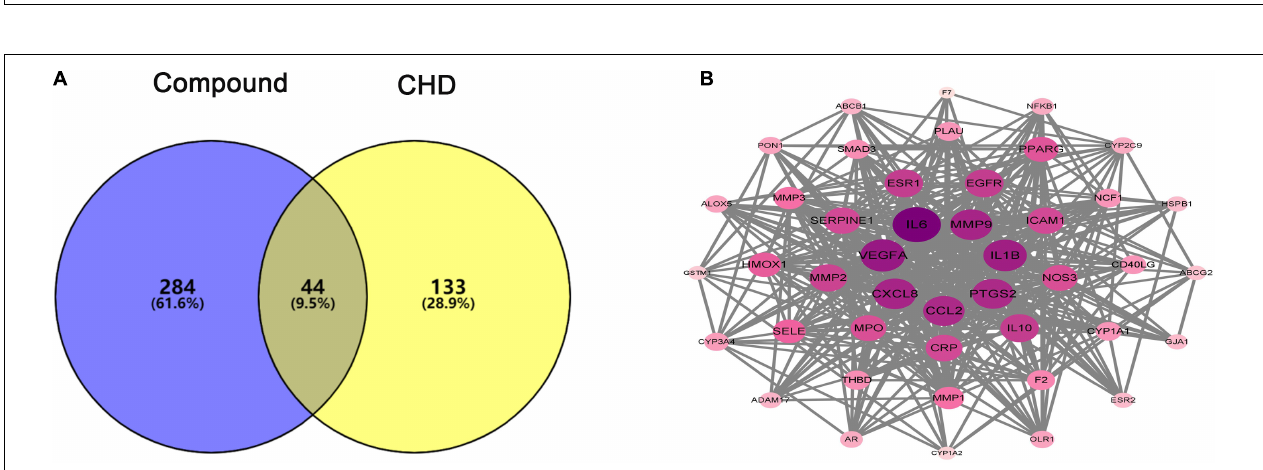
FIGURE 4 | Venn diagram and PPI network of compound-CHD targets. (A) Venn diagram of intersecting targets of hawthorn leaves and CHD. (B) PPI network of compound-CHD targets.